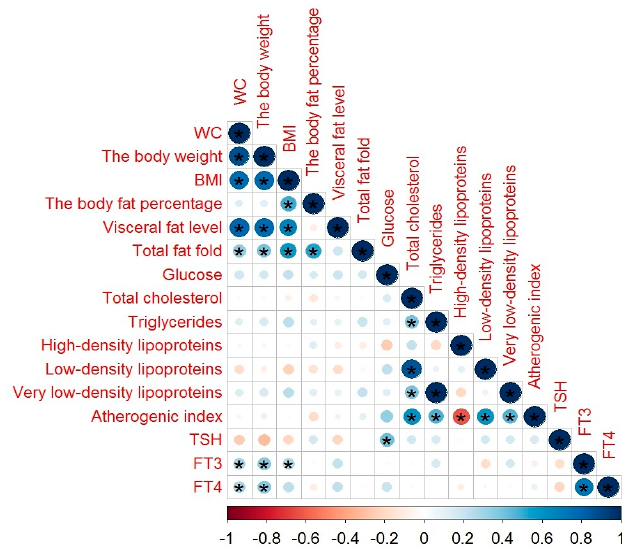
Figure 1. The correlation between body fat parameters, glucose and lipid profiles, TSH, and THs levels in schizophrenia patients with MetS: in this figure, red and blue circles mean negative and positive correlations, respectively; the size and color intensity of circles are proportional to the correlation coefficient; * p -value < 0.05; in the bottom, the legend of color intensity shows the rate of correlations and the corresponding relations.